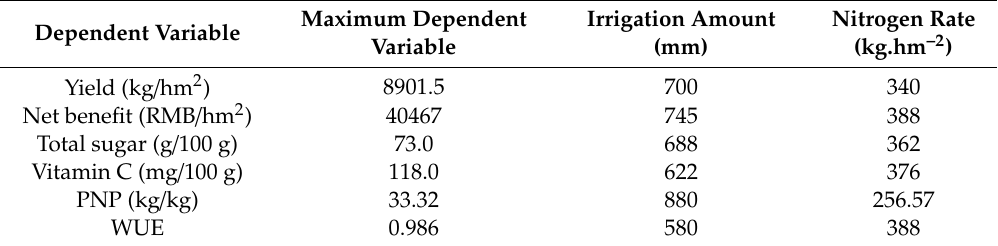
Irrigation corresponding to maximum yield, net benefit, total sugar, vitamin C, partial productivity of nitrogen fertilizer (PNP), and water use e ffi ciency